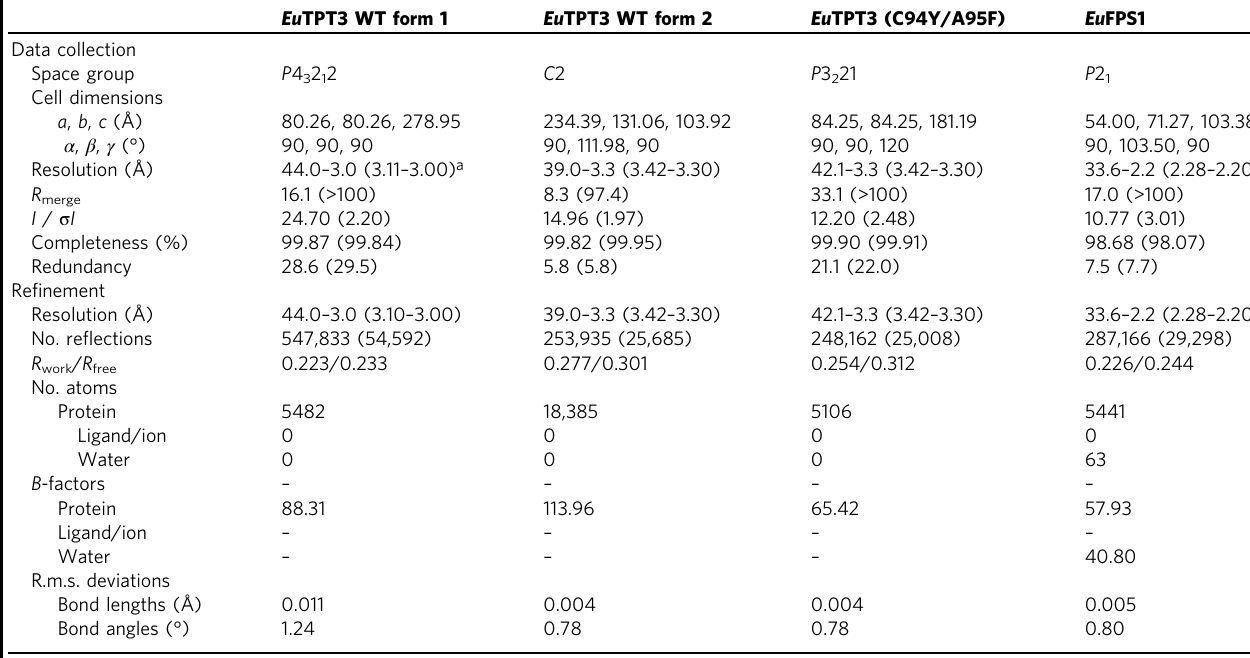
Table 1 Data collection and re fi nement